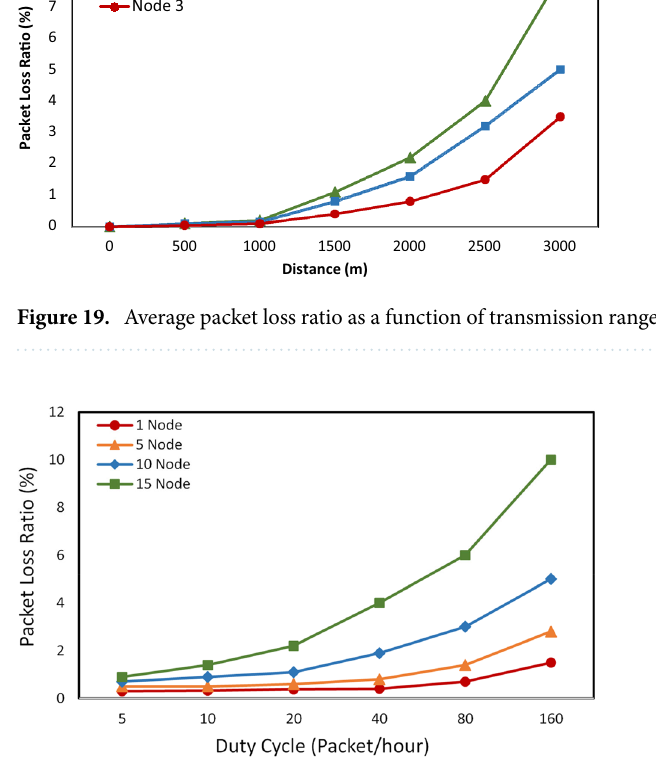
Figure 20. Average packet loss ratio as a function of duty